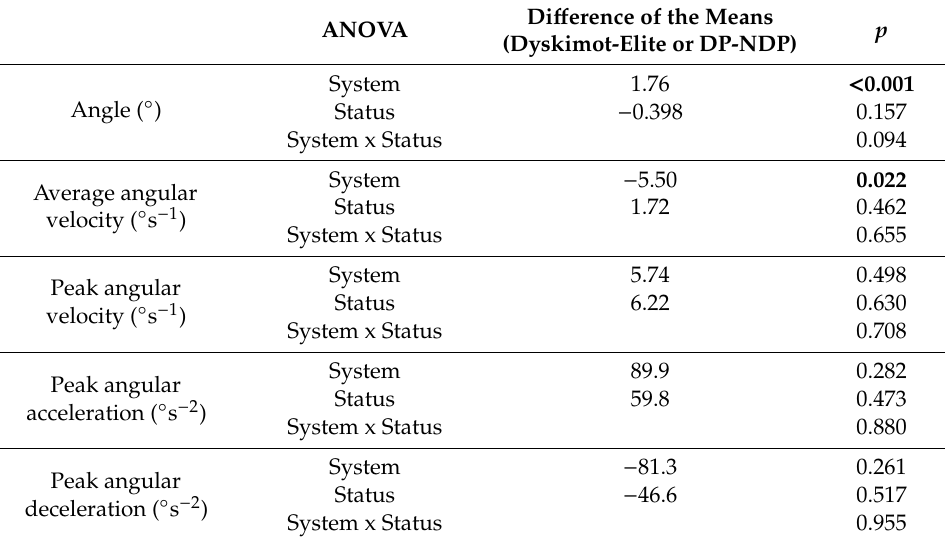
Table 2. Results of the two-way ANOVA performed on the parameters. p values are given for the di ff erences between Elite and DYSKIMOT (System), between DP and NDP (Status) and for the interaction e ff ect System x Status. p values lower than 0.05 are given in bold font. Di ff erence of the Means ANOVA